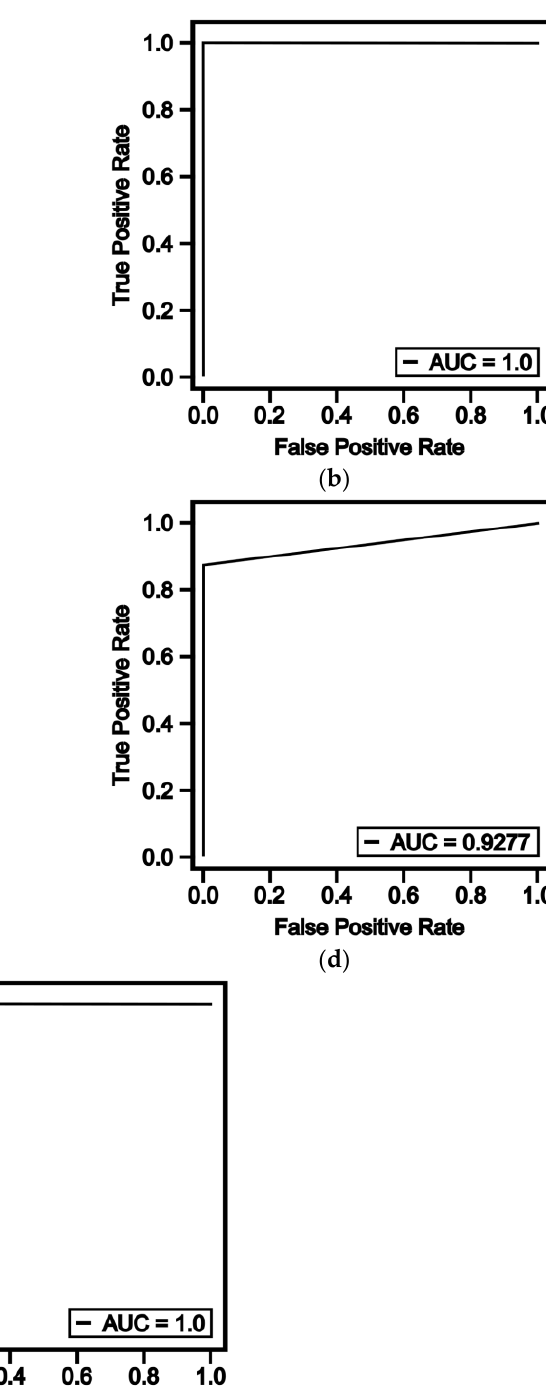
Figure 9. Comparison of ROC curves for ( a ) random forest, ( b ) logistic regression, ( c ) support vector machine, ( d ) Naïve Bayes and ( e ) Adaboost.